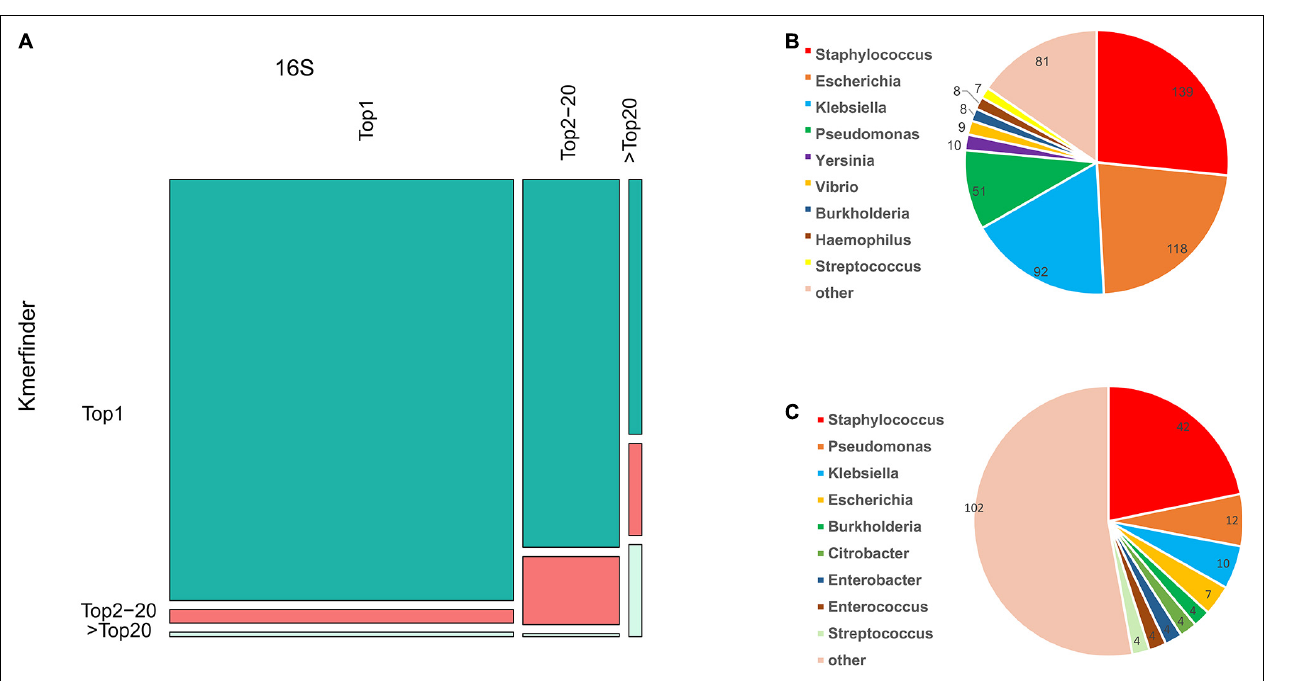
FIGURE 3 | Comparison of accuracy in species identification by 16S and KmerFinder in GEBA, FDA-ARGROS, and NCTC-3000 datasets. (A) Mosaic plot of KmerFinder identification and 16S identification compared to the label in the fIDBAC database. (B) Species distribution of off-hit results of 16S identification. (C) Species distribution of off-hit results of KmerFinder